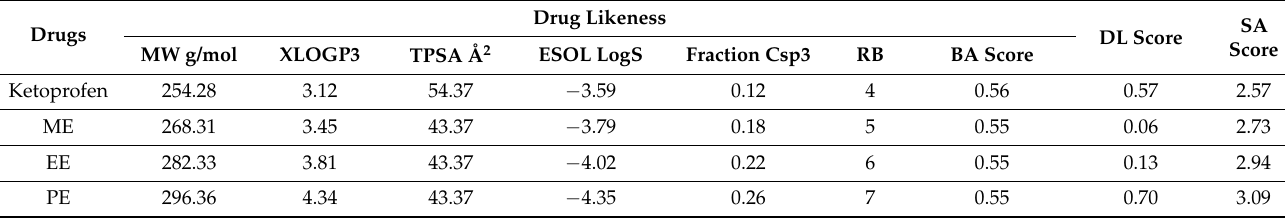
Table 1. ADME parameters of ester prodrugs of ketoprofen representing drug